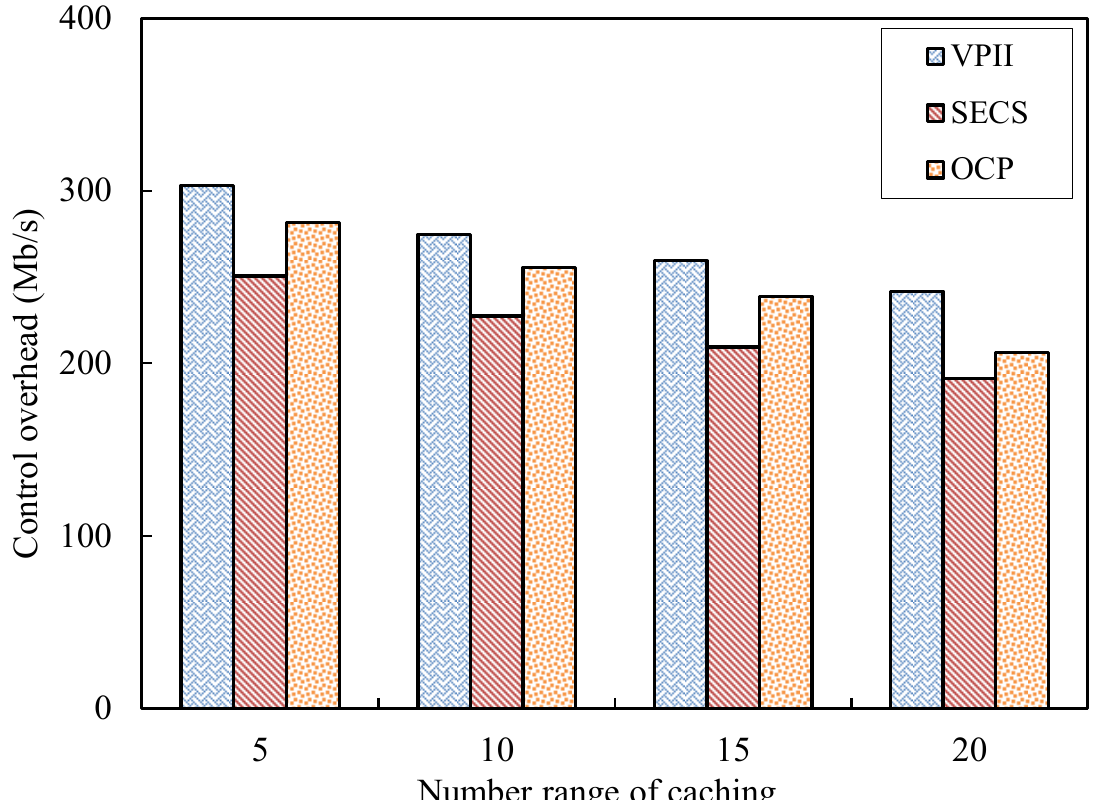
Figure 10. Control overhead against number of cached